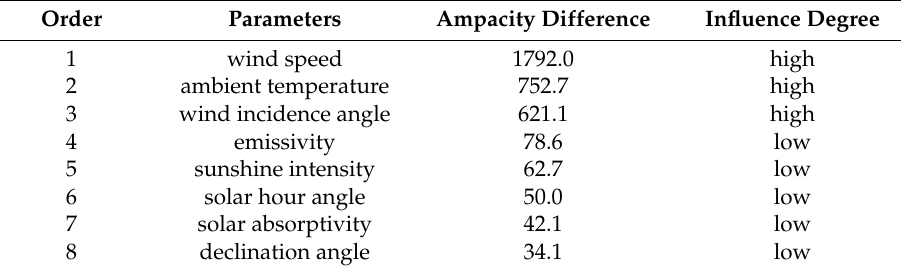
Table 1. Influence of parameters on ampacity.